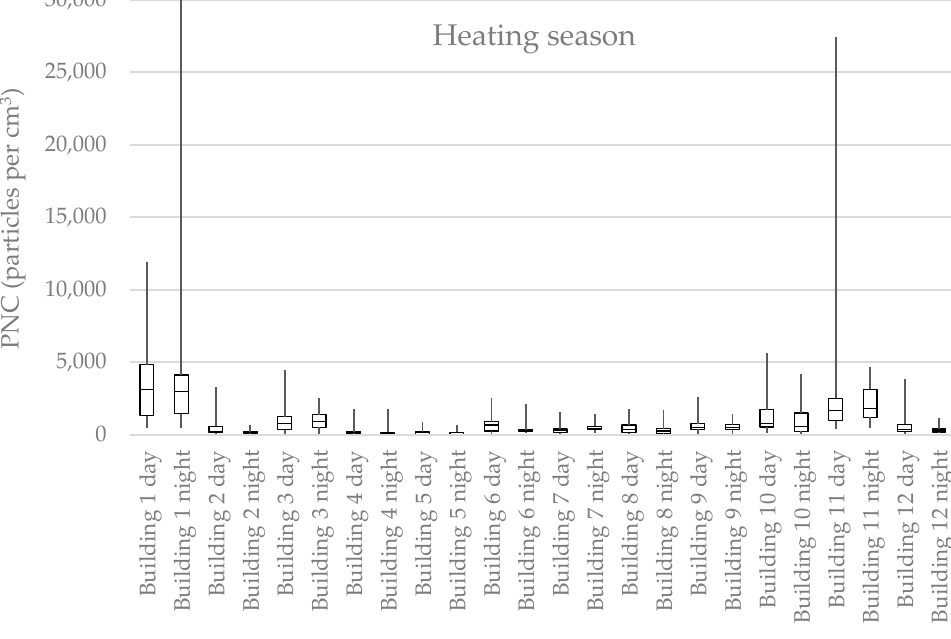
Figure 3. Mean, 25th, and 75th percentile and min and max values for the NP number concentrations in twelve office buildings during daytime (from 6 a.m. until 6 p.m.) and nighttime (from 6 p.m. until 6 a.m.) during a one-week measuring period in the heating season.